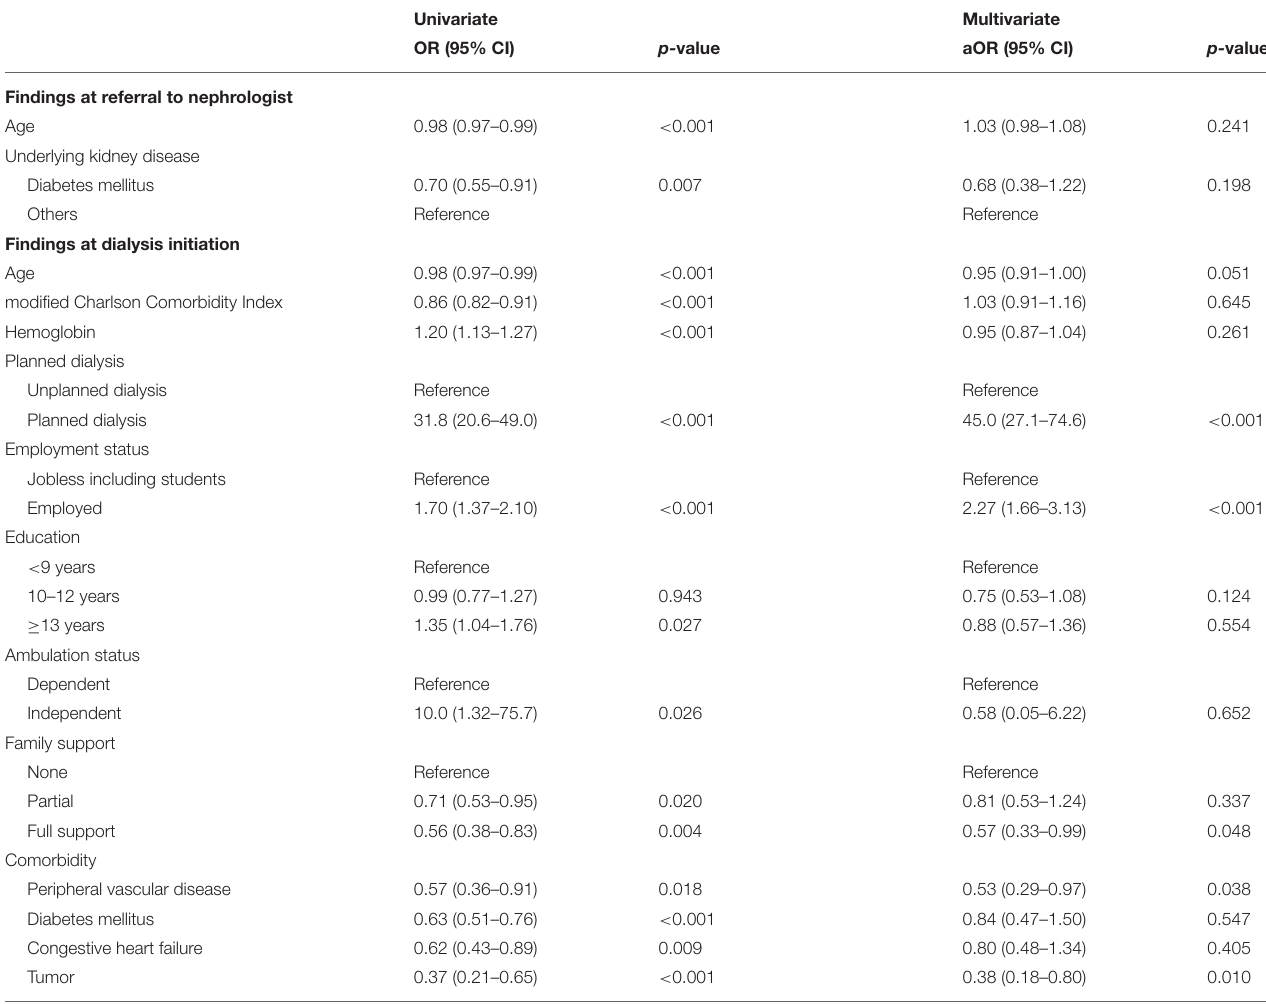
TABLE 3 | Logistic regression analysis of factors associated with selecting peritoneal dialysis in younger